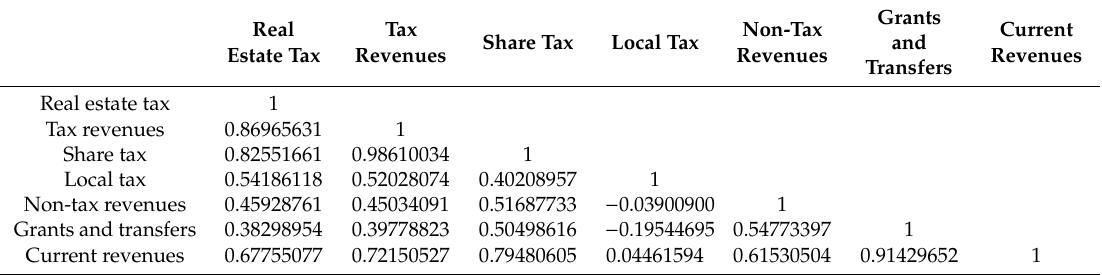
Table 6. Correlation analysis of individual components of current revenues of municipalities in Czech Republic. Real Estate Tax